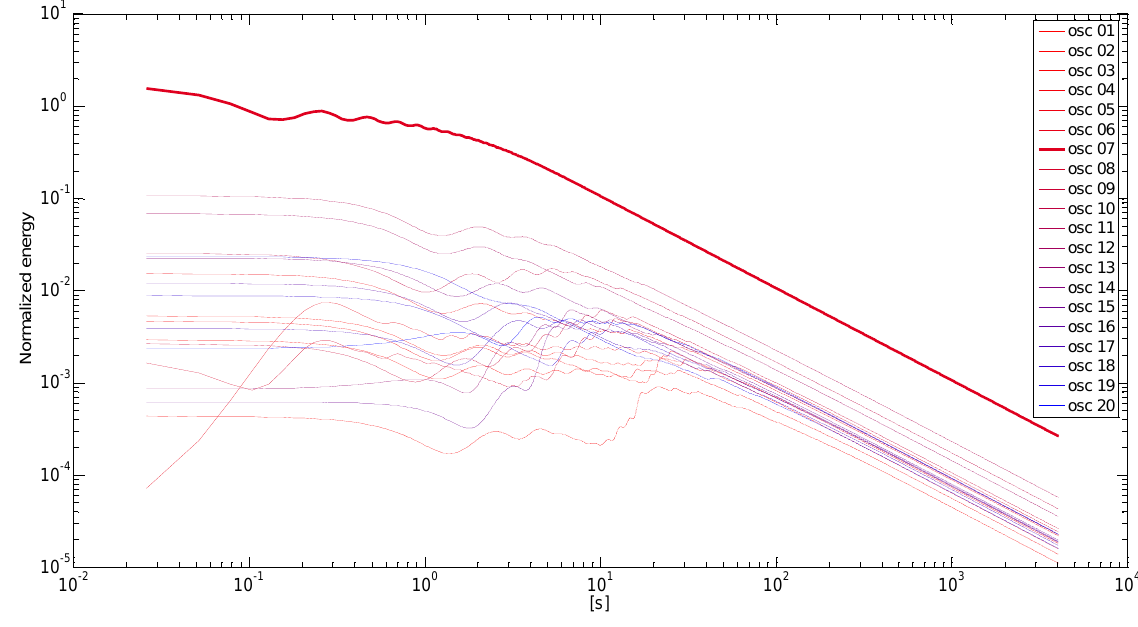
Fig. 16. Chain with mass focus with uniform nondimensional damping coefficient, time energy averages versus time, x, y axes in log scale. Even though damping diminishes the energy storage into the focus, Fig. 14 enlightens   t  remains well